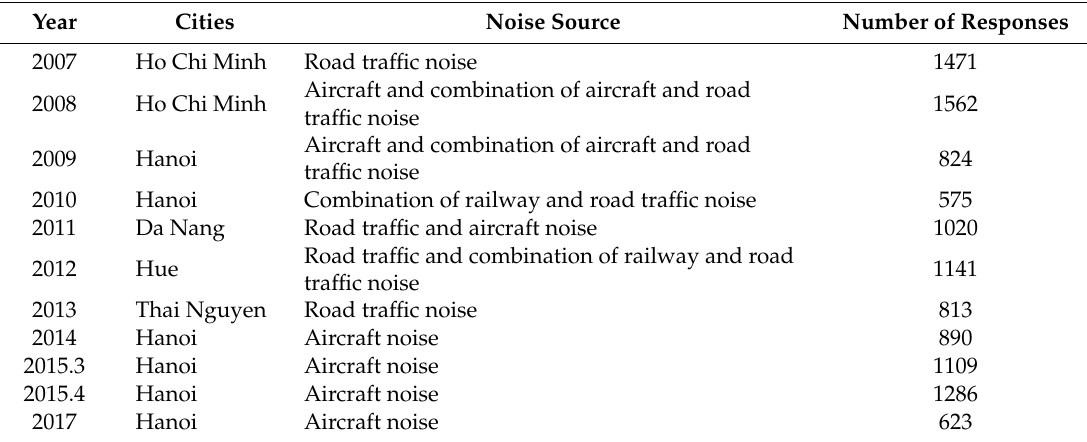
Table 5. List of 11 datasets extracted from the result of the 13 socio-acoustic surveys in Vietnam.